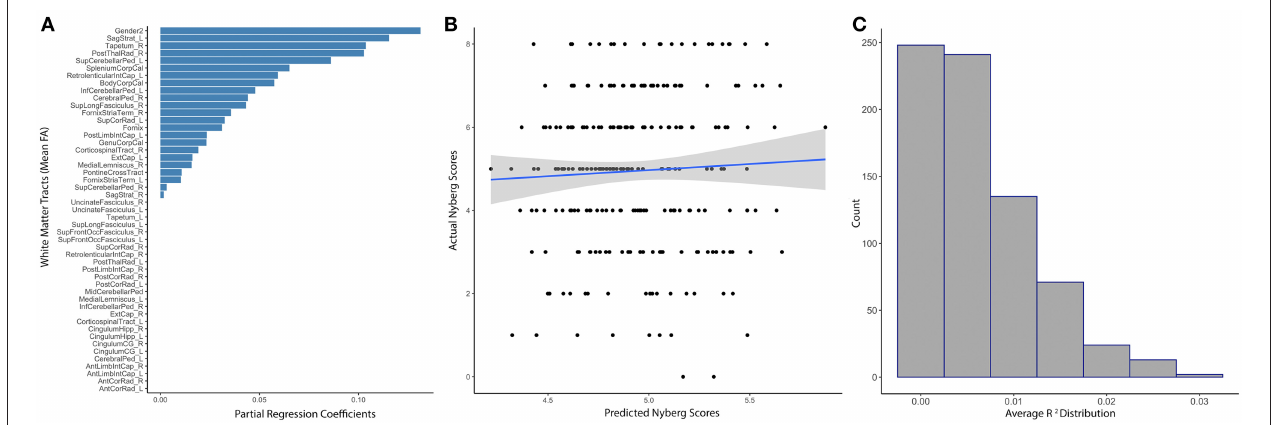
FIGURE 3 | Distributed white matter tract integrity and Nyberg Health Index scores. (A) The absolute value of partial regression coefficients for each tract that remained non-zero after training the initial elastic net model predicting Nyberg Health Index scores. (B) Scatter plot showing the correlation between model-predicted and actual Nyberg Health Index scores ( R 2 = 0.0025, p = 0.44). (C) Distribution of R 2 s gathered from the subsequent ensemble modeling using 1,000 iterations of the elastic net model, which did not reveal any non-zero tracts (Ensemble R 2 = 0.0062, 25th − 75th quartile = 0.0001–0.008). Sex was included as a covariate in all